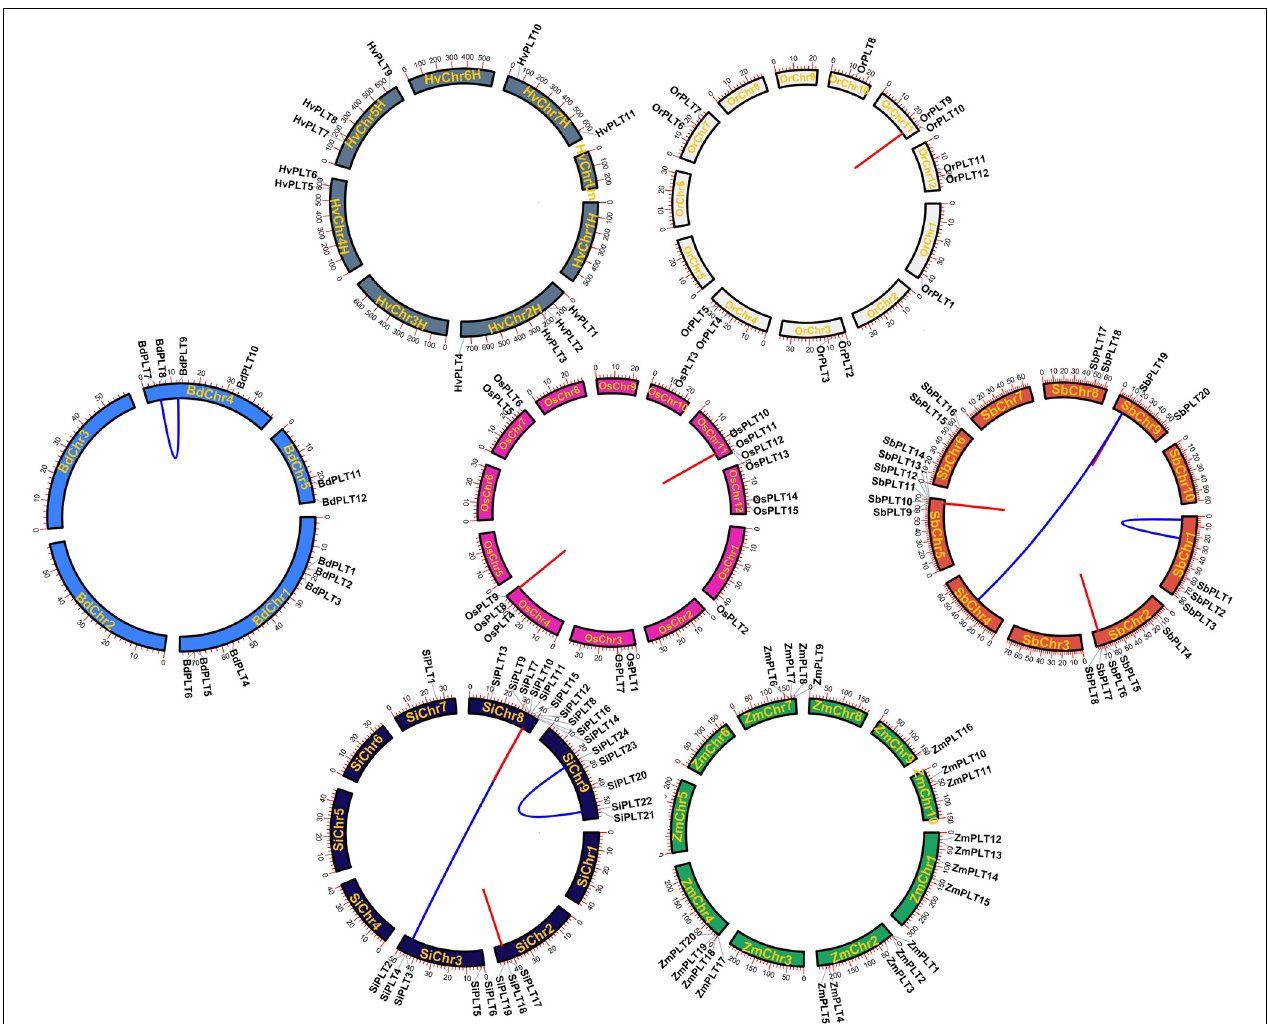
FIGURE 3 | The chromosome locations and gene duplication events of PLT genes in seven species, namely, Brachypodium distachyon (Bd), Hordeum vulgare (Hv), Setaria italica (Si), Sorghum bicolor (Sb), Zea mays (Zm), Oryza rufipogon (Or), and Oryza sativa ssp. japonica (Os). The red line meant tandem duplication and the blue line meant whole-genome duplication/segmental duplication and tandem